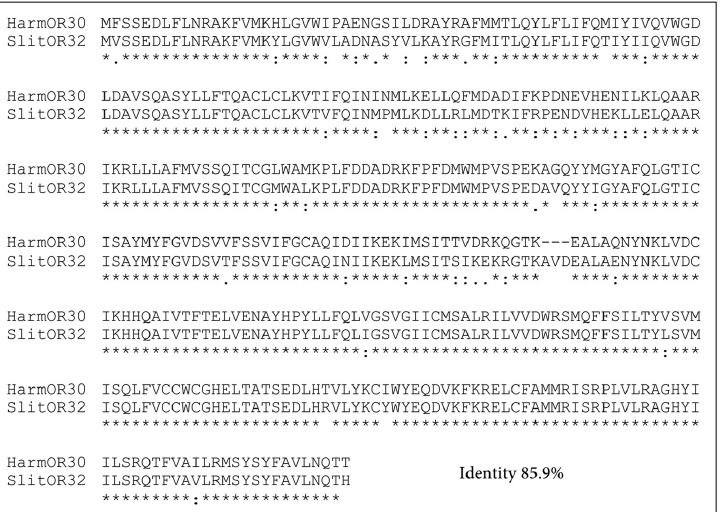
Figure 3. Sequences alignment of HarmOR30 and SlitOR32. Amino acid residues differences are indicated as highly (:) and moderately (.). The asterisks indicate identity across both sequences.